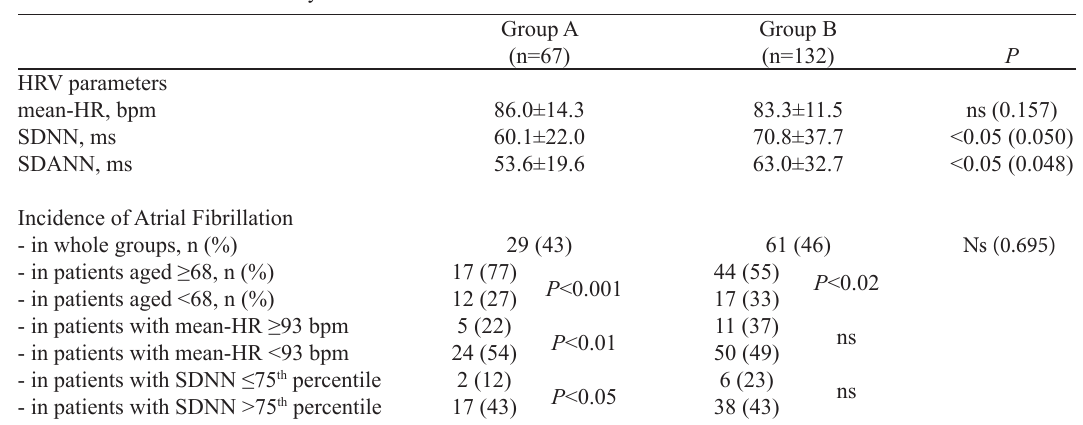
Table 2. Main results of the study.